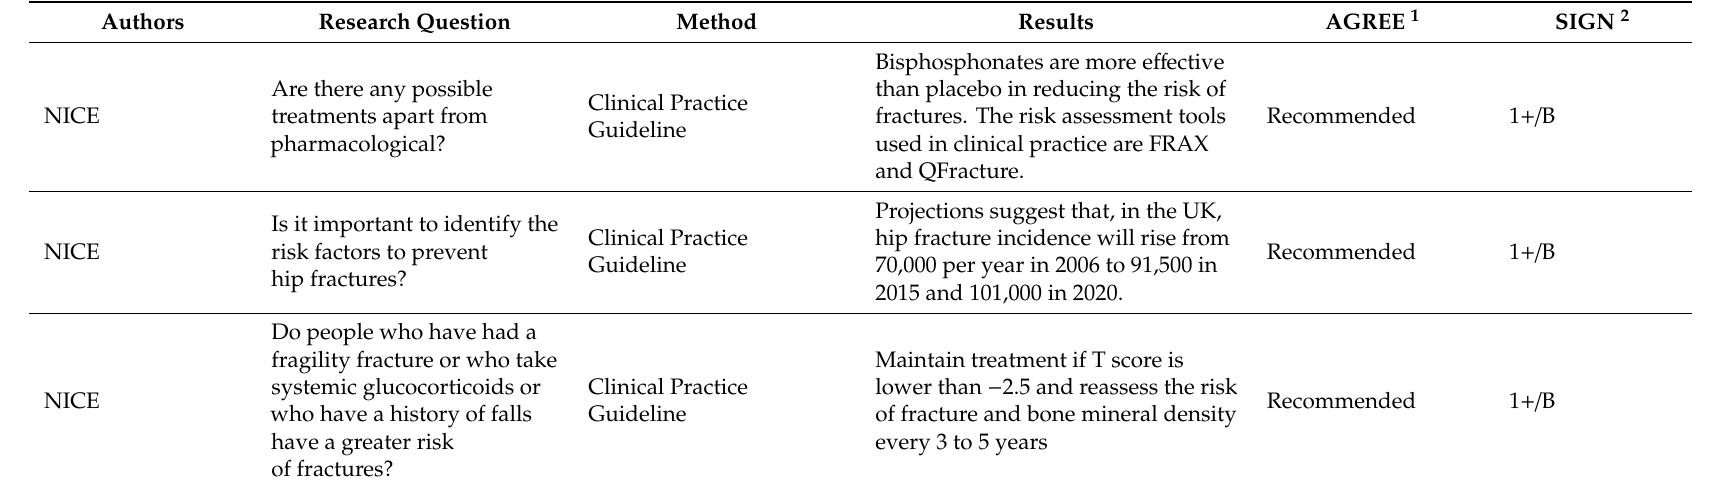
Table 5. Results from clinical practice